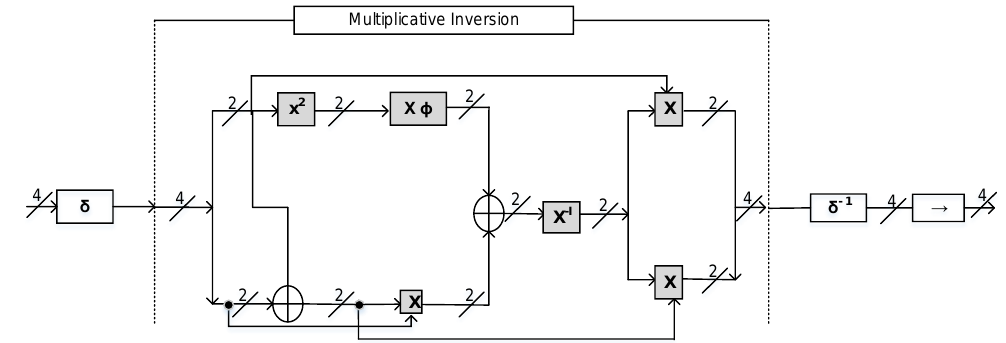
Figure 2. Proposed S-box structure in finite fields. The affine and the inverse transformations are carried out in the field GF (2 4 ) and the multiplicative inversion is carried out in the composite field GF ((2 2 ) 2 ) .